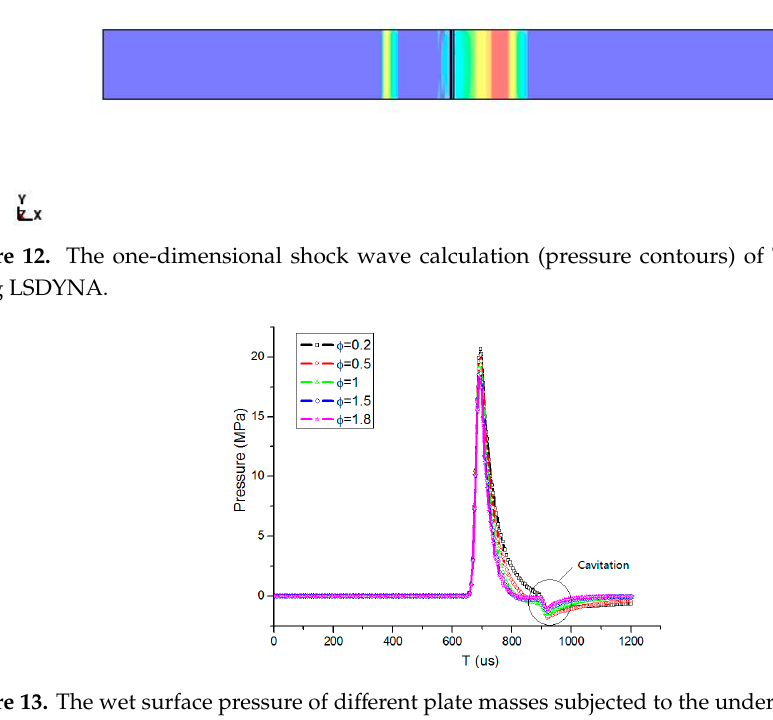
Figure 13. The wet surface pressure of different plate masses subjected to the underwater shockwave (Taylor’s model).